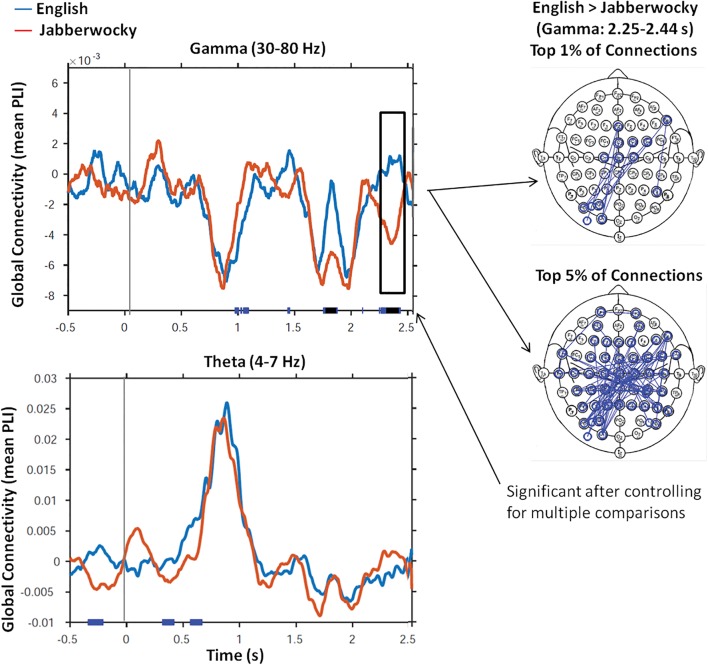
Global Connectivity. This figure shows time series of global connectivity (mean PLI values) for English (blue) and Jabberwocky (red) sentences for the gamma and theta frequency bands. Results of the running t-tests that compared mean PLI values for English versus Jabberwocky at each time point are presented along the x-axis of each figure (blue: p < 0.05; black: p < 0.01). Only the effect in the gamma frequency range (30–80 Hz) remained significant after controlling for multiple comparisons (pcorr < 0.05). The head maps show the electrode – electrode connections that contributed most to the gamma connectivity effect in the 2.25–2.44 s time window.